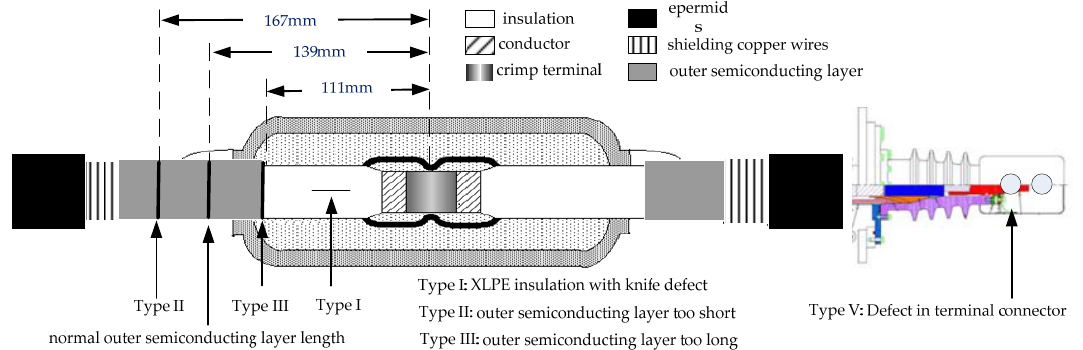
Figure 4. Experimental defect models in XLPE power cable.